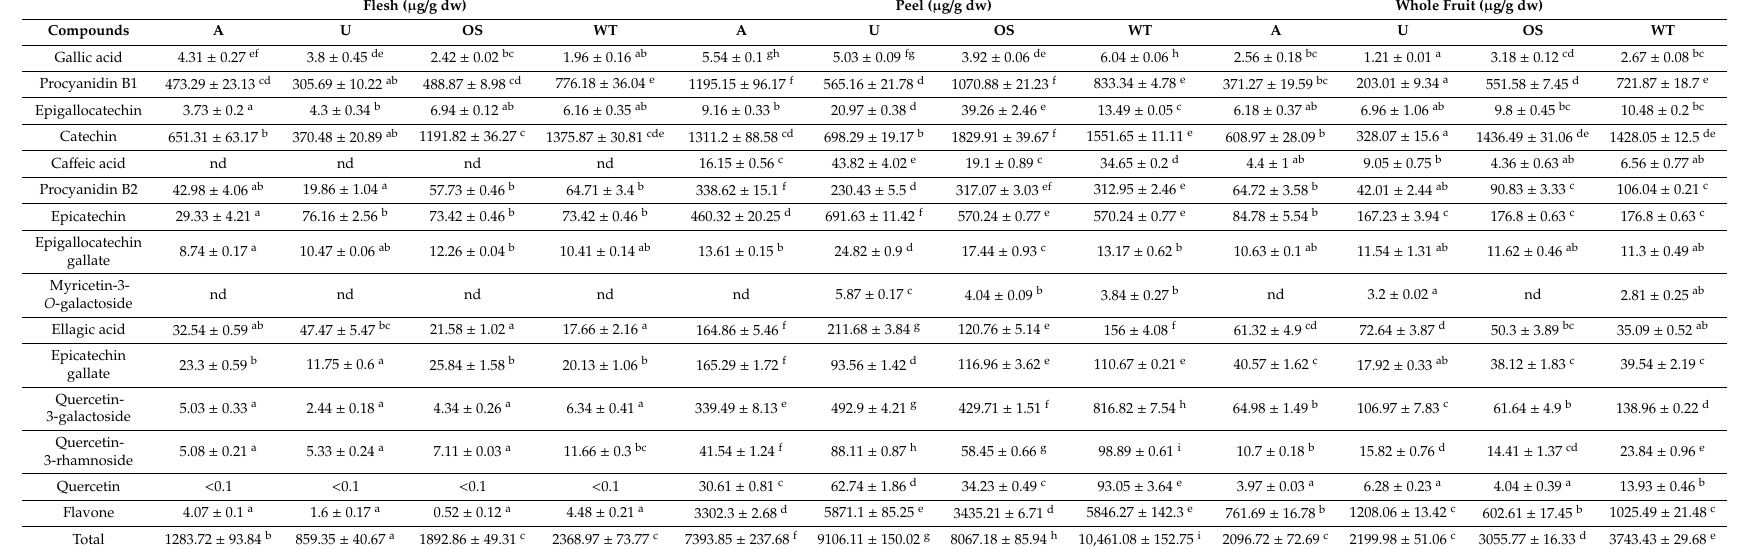
Table 4. Concentrations of phenolic compounds in feijoa flesh, peel and whole fruit of four cultivars. Flesh( µ g /